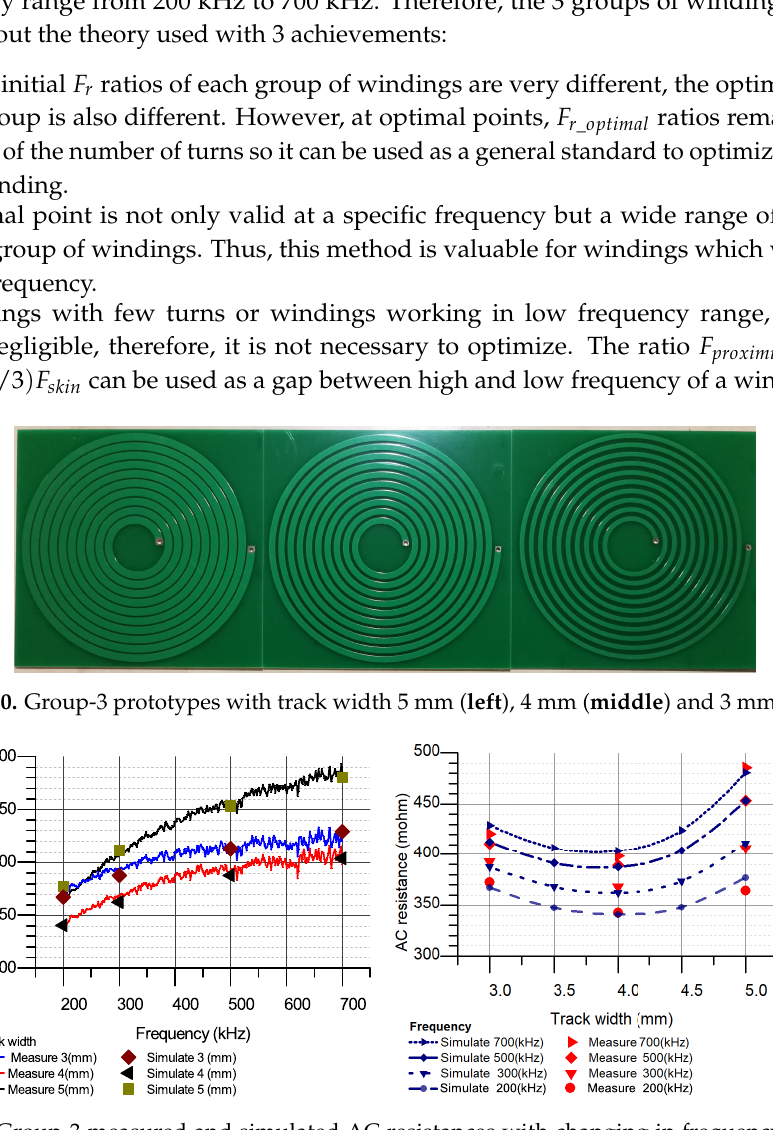
Figure 21. Group-3 measured and simulated AC resistances with changing in frequency ( left ) and track width ( right